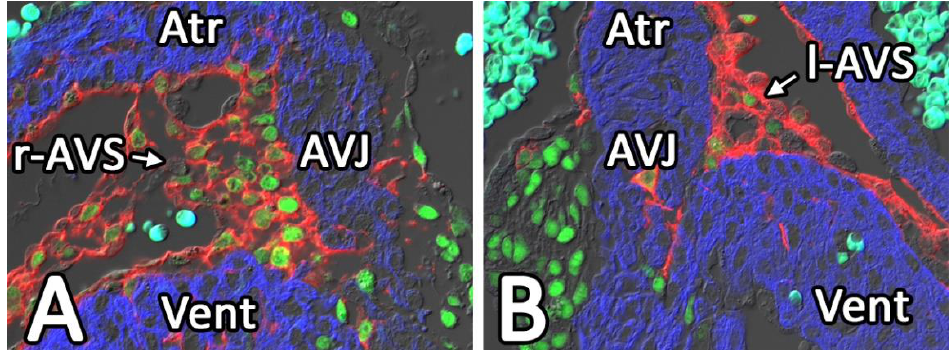
Figure 8. SOX9 is upregulated in AV-EPDCs as they migrate from the epicardium toward the right ( A ) and left ( B ) AV junction. A section of a 13 ED WT1 cre ;R26 mT/mG heart was stained for SOX9 (green), EGFP (immunolocalized and visualized in the red channel) to localize EPDCs, and the myocardium (myosin heavy chain) in blue. Atr, atrium; AVJ, (myocardial) AV junction; l-AVS, left AV sulcus; r-AVS, right AV sulcus; Vent,